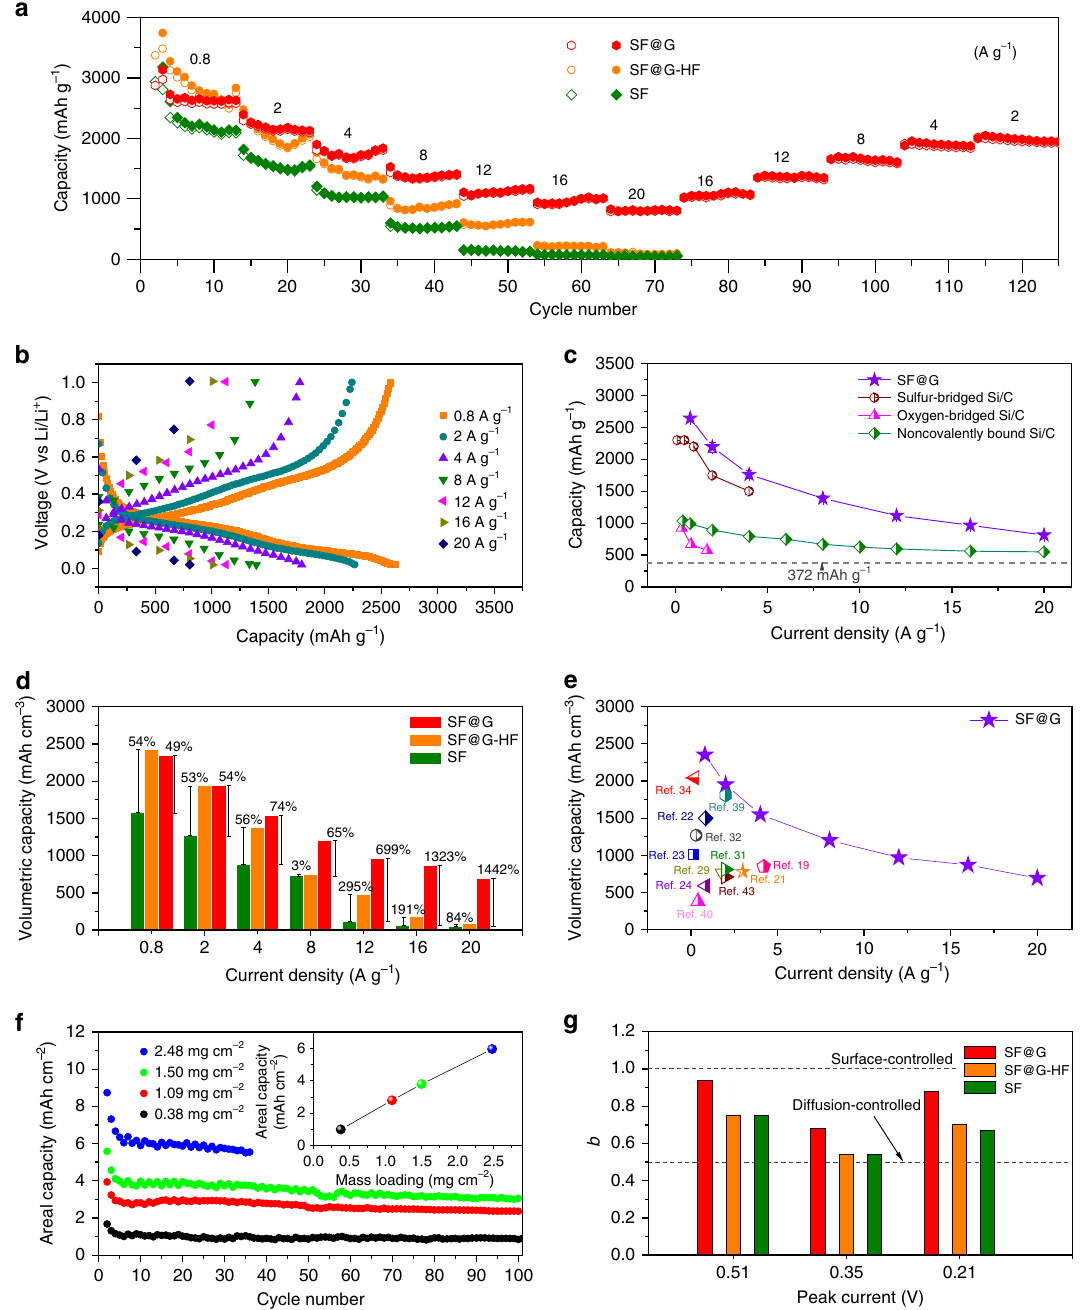
Fig. 4 Electrochemical characteristics of SF@G tested at different rates. a Capacity of SF@G, SF@G-HF, and SF cycled at different rates from 0.8 to 20Ag − 1 (ten cycles for each rate). b Galvanostatic charge/discharge pro fi les of SF@G at various rates. c Capacity of SF@G at annotated rates, comparing with typical Si/C anodes with conventional interfacial binding modes as noted. d Volumetric capacity of SF@G, SF@G-HF, and SF at various rates. e Volumetric capacity at annotated current rates for SF@G with some representative Si anodes reported in the literatures as noted. f Areal capacity of SF@G at various active material mass loadings. g The b -value of anodic (0.51V and 0.35V) and cathodic (0.21V) peaks for SF@G, SF@G-HF, and SF, derived from cyclic voltammetry (CV) experiments at various sweep